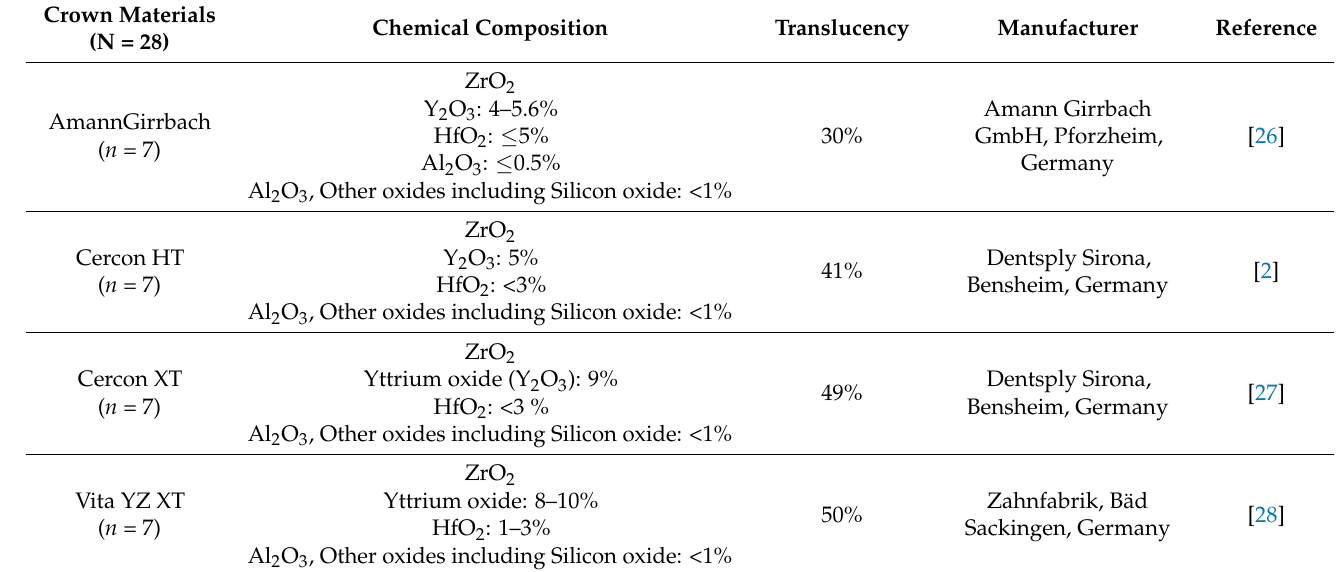
Table 1. Summary of the crown materials used in this study.